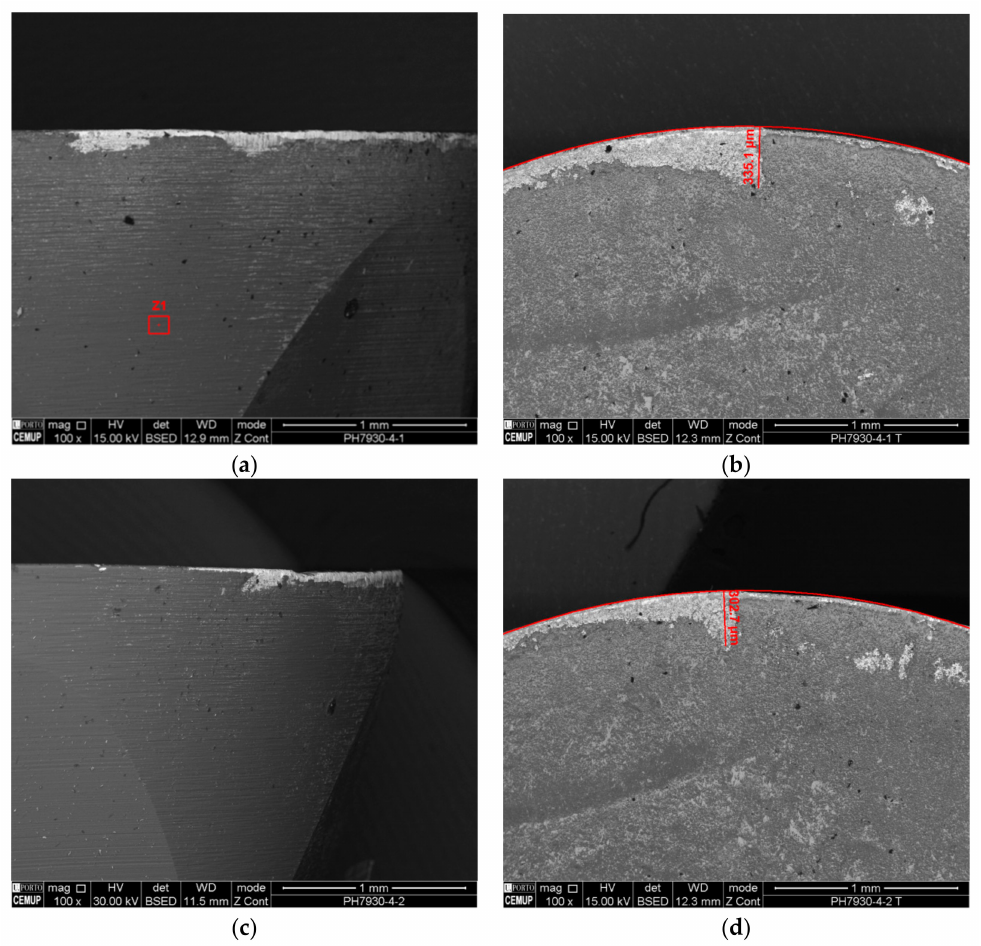
Figure 7. ( a ) and ( c ) Flank wear (VB) of PVD PH7930-L1 and PH7930-L2 cutting inserts, respectively; ( b ) and ( d ) rake face / land wear (KB) of PVD PH7930-L1 and PH7930-L2 cutting inserts, respectively.